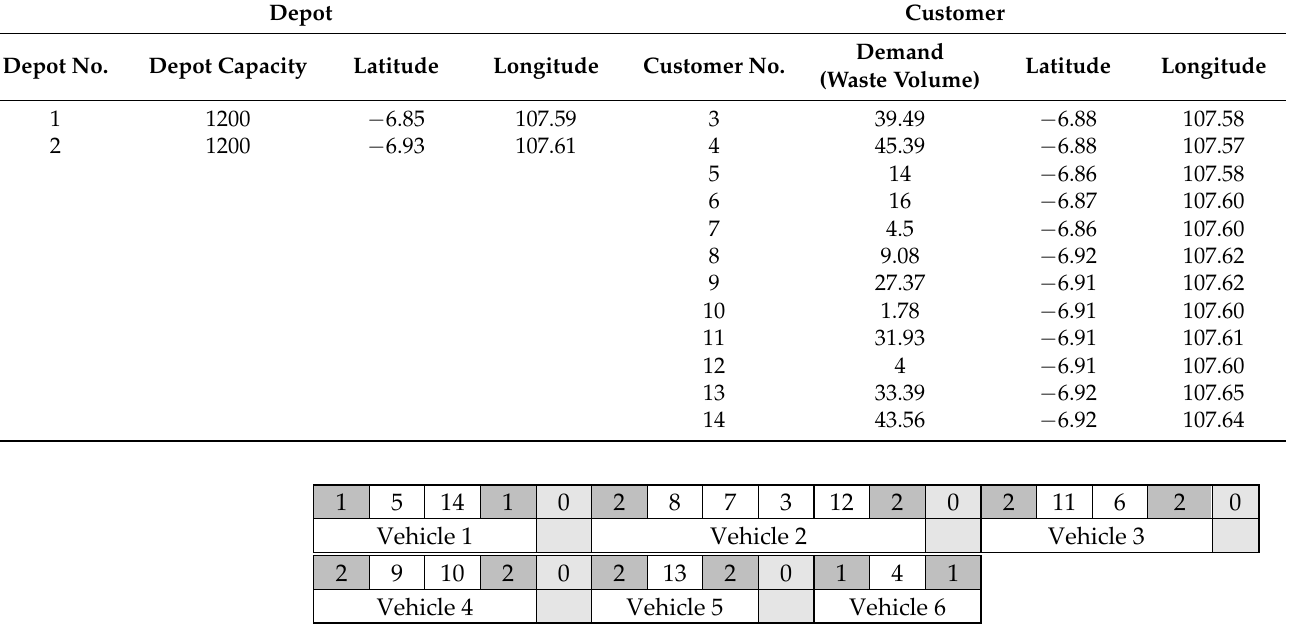
Table 2. An example of depot and customer attributes.